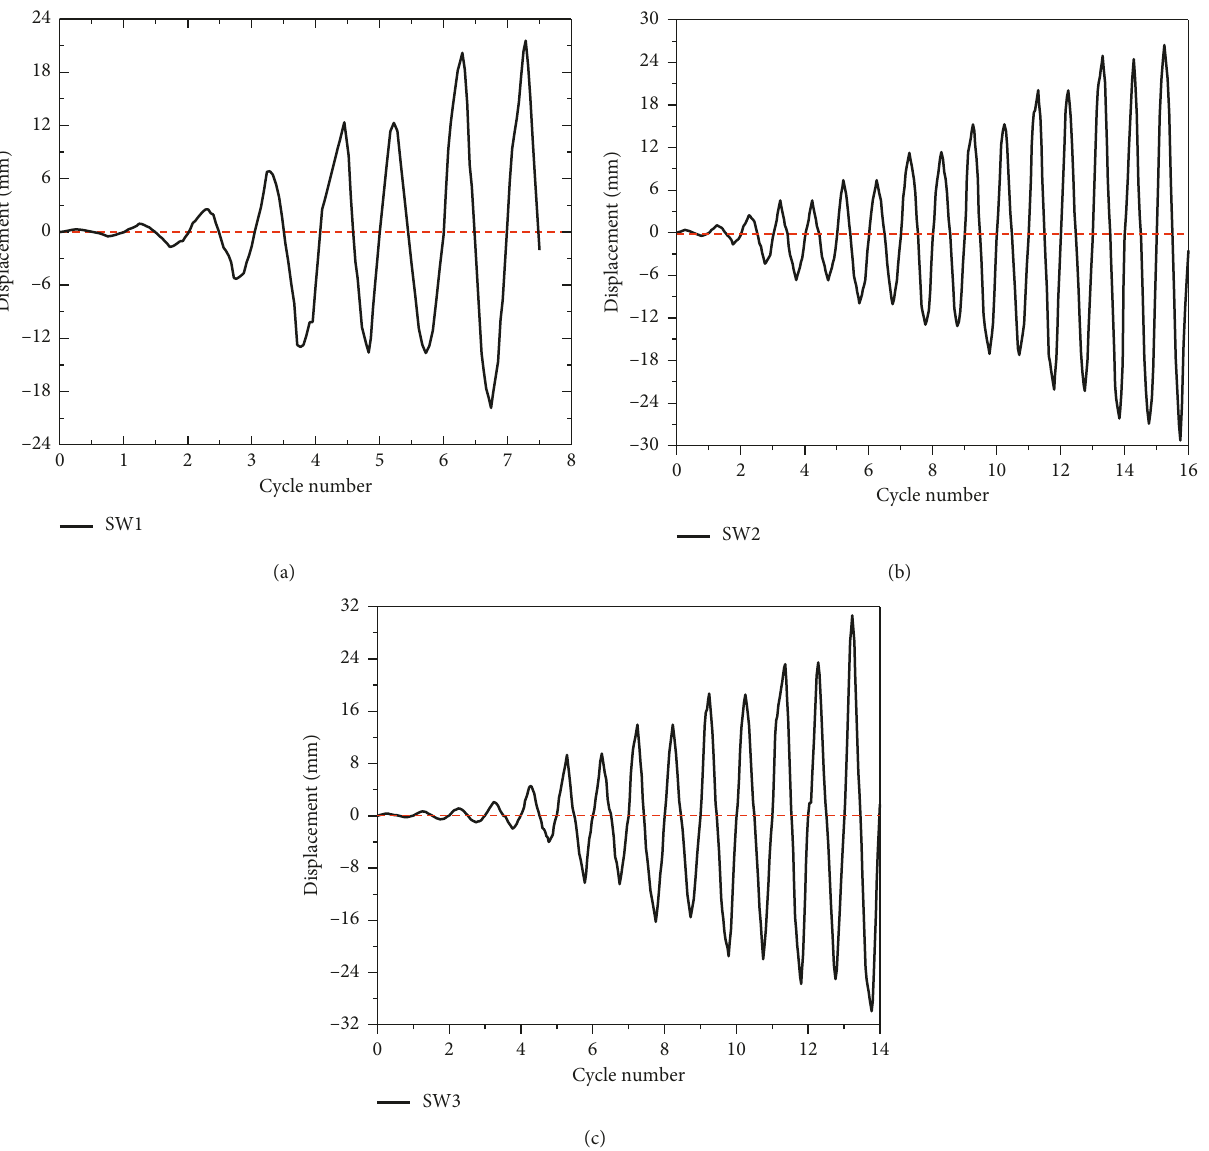
Figure 13: The test loading